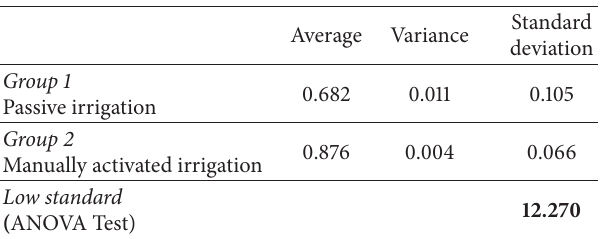
Table 1: Comparative analysis of average values of infiltration between group 1 and group 2.